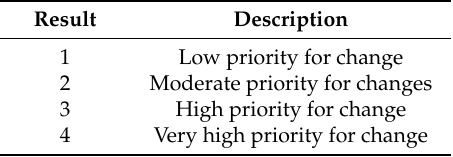
Table 4. Interpretation of results for the Suzanne Rodgers module.